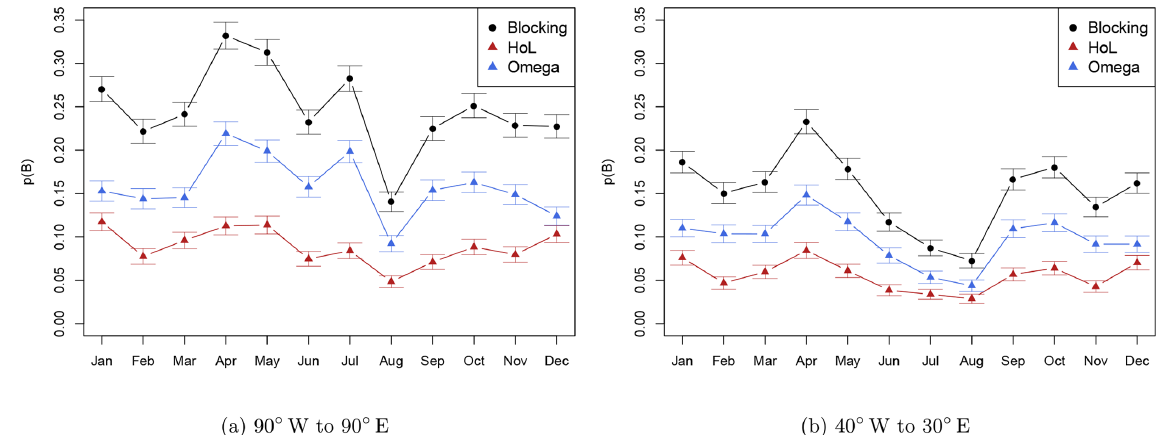
Figure 9. Blocking probability estimated for individual months for blocking in general as well as separately for high-over-low and omega. (a) Whole domain (90 ◦ W to 90 ◦ E) and (b) Euro-Atlantic subsection (40 ◦ W to 30 ◦ E). Whiskers show 95% confidence intervals assuming Gaussian asymptote for estimating binomial